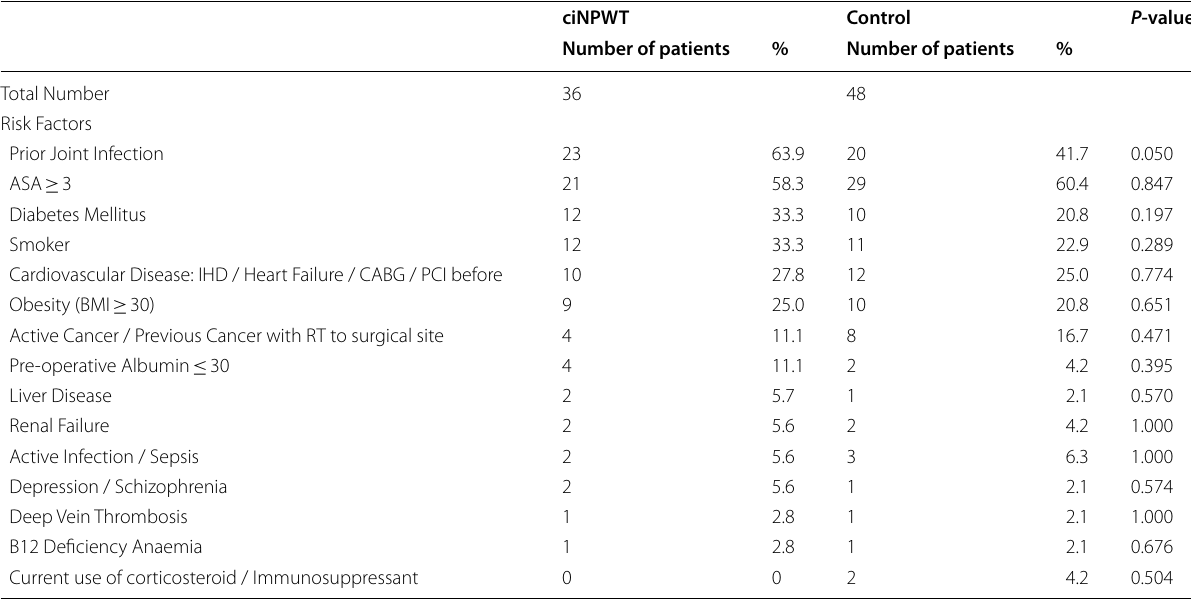
Table 2 Patient risk factors / Comorbidities